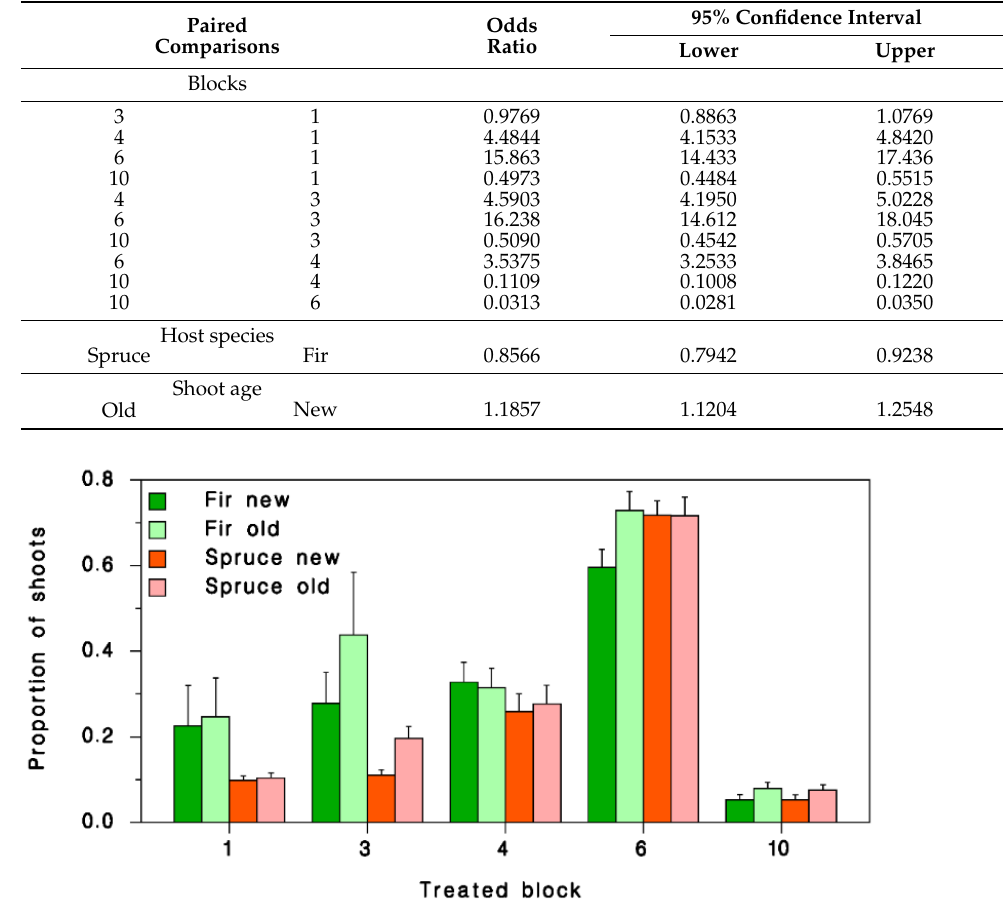
Table 1. Results of binomial logistic regression analysis of the proportion of shoots bearing at least one droplet of CONFOUND SBW in treated Blocks 1, 3, 4, 6 and 10 (paired comparison odd ratios). Paired Odds Comparisons Ratio